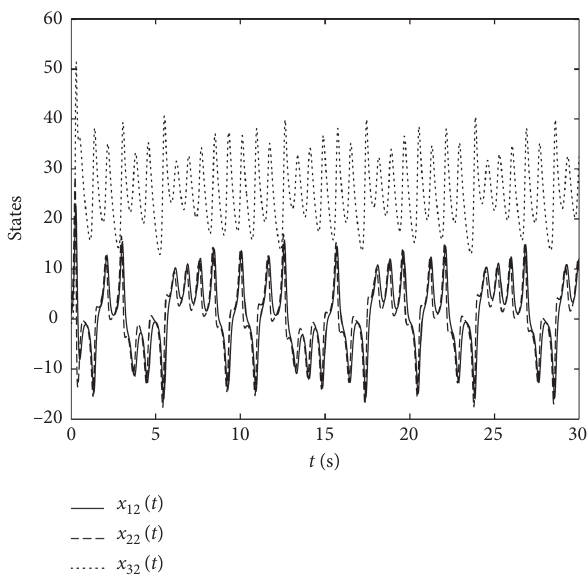
Figure 3: The state of subsystem 2 in nonlinear fractional order interconnected